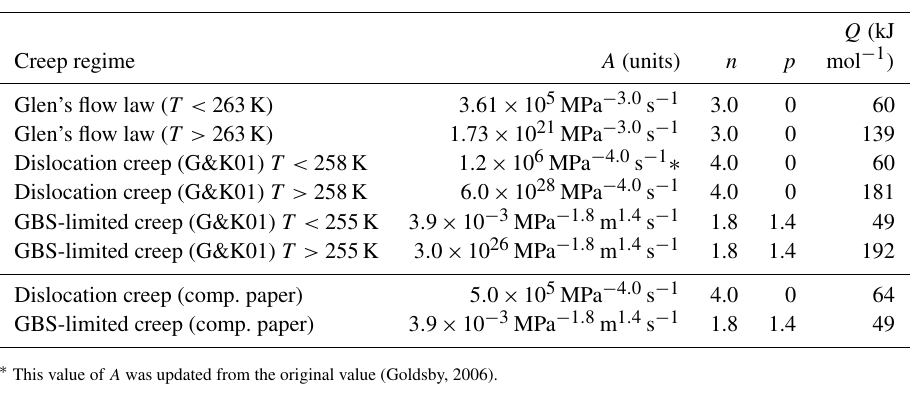
Table 2. The flow law parameters of Glen’s flow law (Paterson, 1994) and the end-members of the original composite flow law for dislocation creep and GBS-limited creep. The corrected flow law parameters used in the companion paper are also shown below the dotted line. The flow law parameters used in this paper are shown in Table 3.